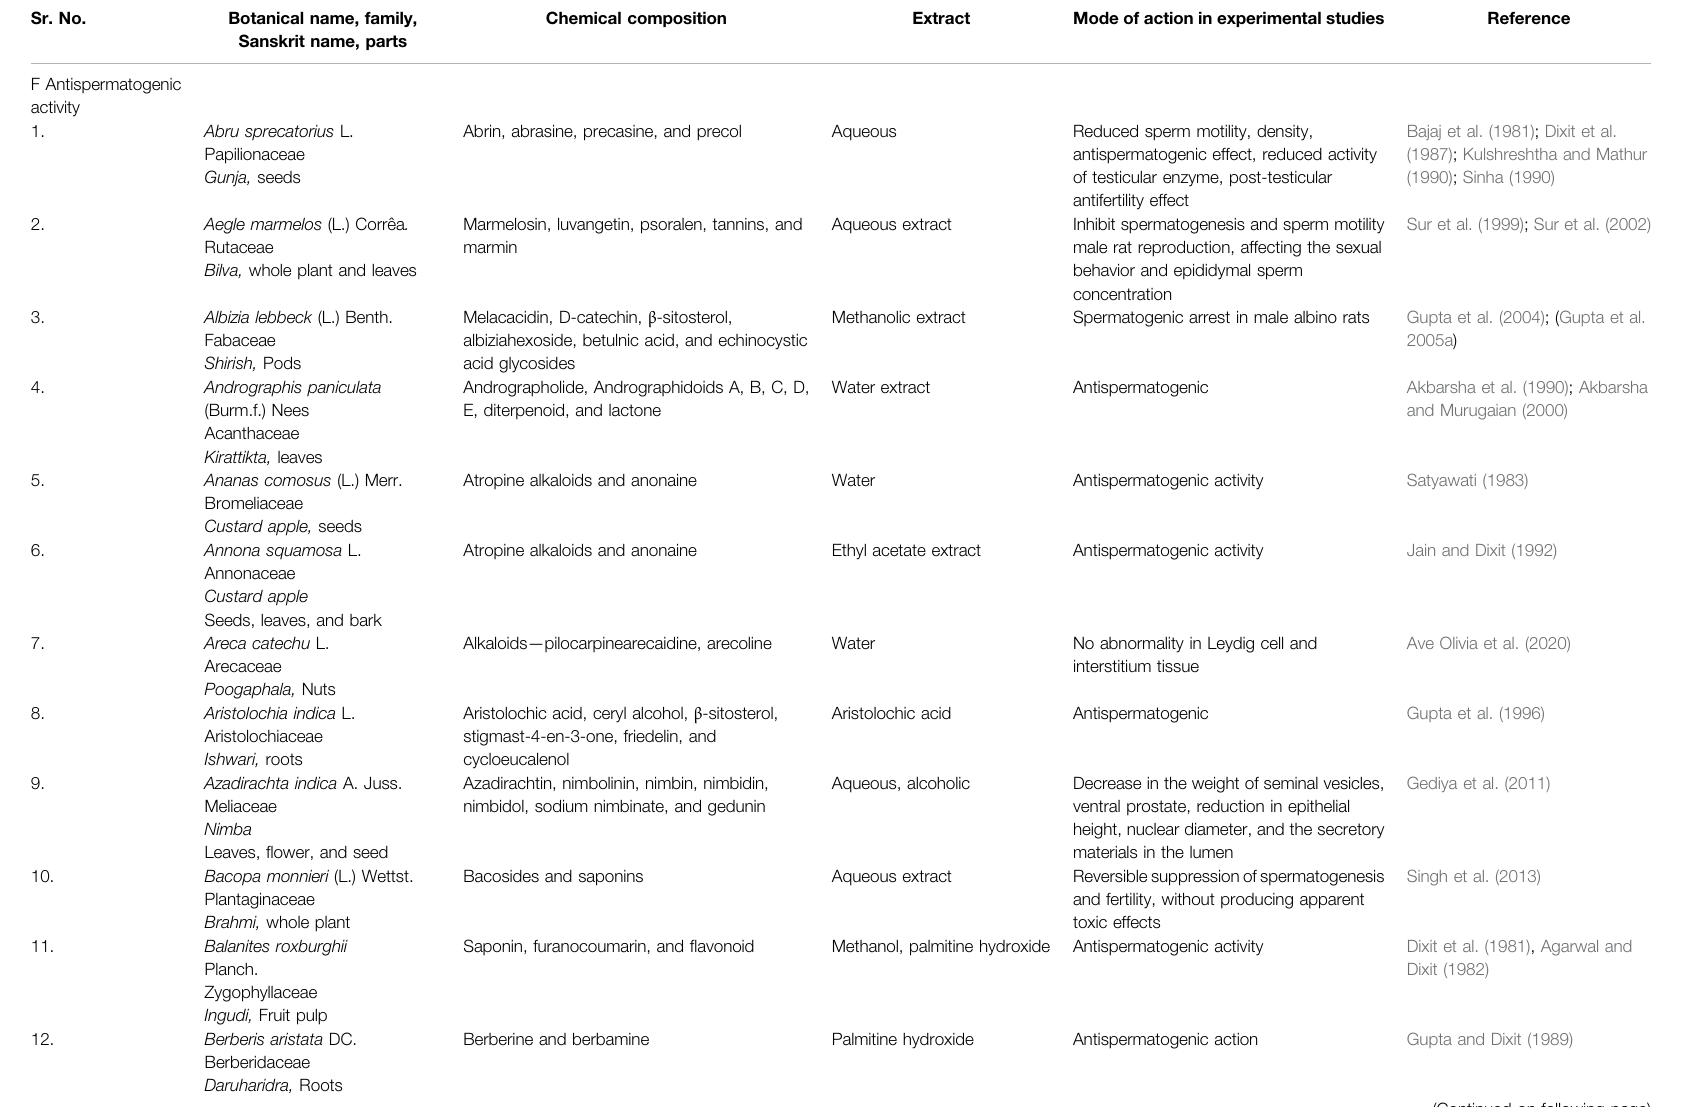
TABLE 2 | ( Continued ) Medicinal plants and their phyotoconstituents validated for various female/male contraceptive activities. Different contraceptive activities studied on medicinal plants could be categorized as follows. Female contraceptive activities: (2A) anti-implantation activity, (2B) aborti fi cation, (2C) antifertility, (2D) antiovulatory, and (2E) antiestrogenic activity. Male contraceptive activities: (2F) antispermatogenic, (2G) spermicidal, and (2H) antiandrogenic